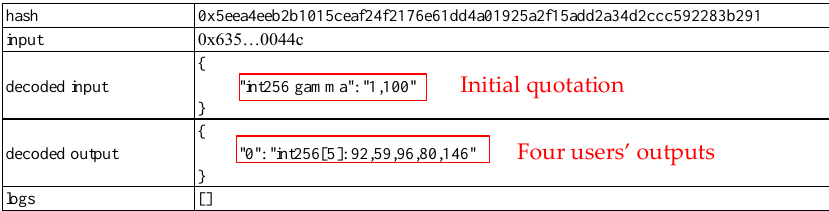
Figure 4. Buy ers’ demand value at the initial quoted price. Figure 4. Buyers’ demand value at the initial quoted price.